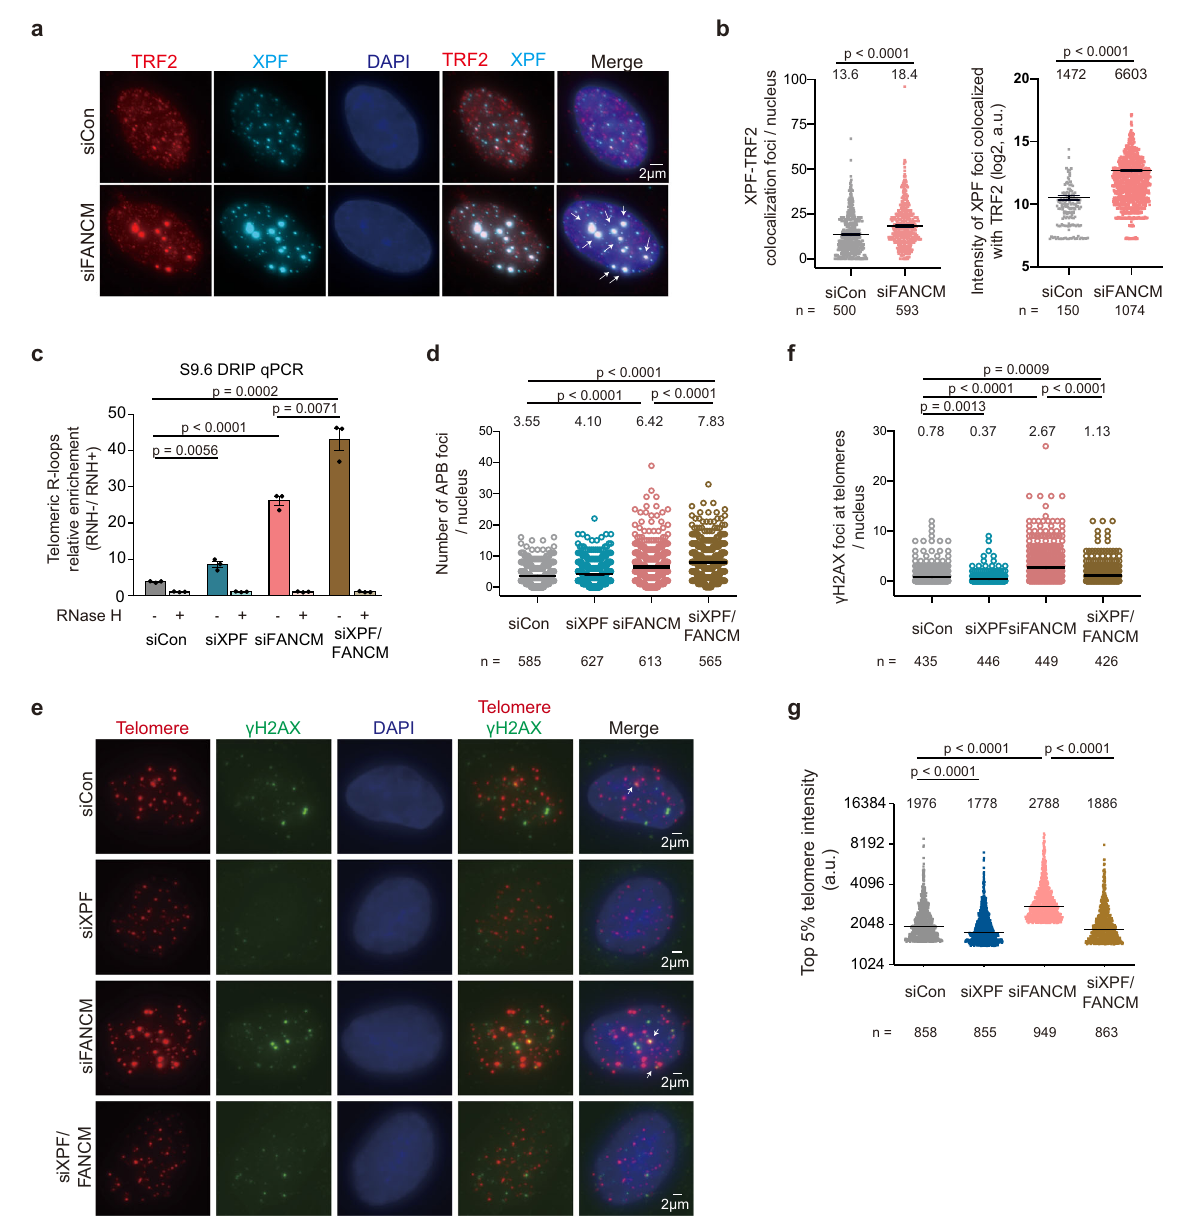
Fig.5|DDRatALTtelomeresinducedbyFANCMde fi ciencyismediatedbyXPF. a Representative images of TRF2 and XPF co-immunostaining in U2OS cells trans- fected with FANCM siRNAs for 3 days. Arrows indicate the colocalization events. b Quanti fi cation of colocalization events in ( a ). The number of XPF-TRF2 coloca- lization per nucleus (left). The intensity of XPF foci that are colocalized with TRF2 (right). P -valuesbytwo-sidedMann-Whitneytest.Bars, mean±SEM. n , cellnumber (left)ornumberofXPFfoci(right).Dataofthreeindependentexperiments. c DRIP- qPCRtodetecttelomericR-loopsinU2OScellsaftertransfectionwithcontrol,XPF, or FANCM siRNAs for 3 days. Relative R-loop levels were normalized to the same amountofgenomicDNAtreatedwithRNaseHpriortoDRIP. P -valuesbytwotailed Student ’ s t -test. Bars, mean±SD. Representative of three independent experi- ments. Other replicates show similar trends and are provided in the Source Data fi le. d Quanti fi cation of APBs in U2OS cells transfected with siRNAs. APB foci were